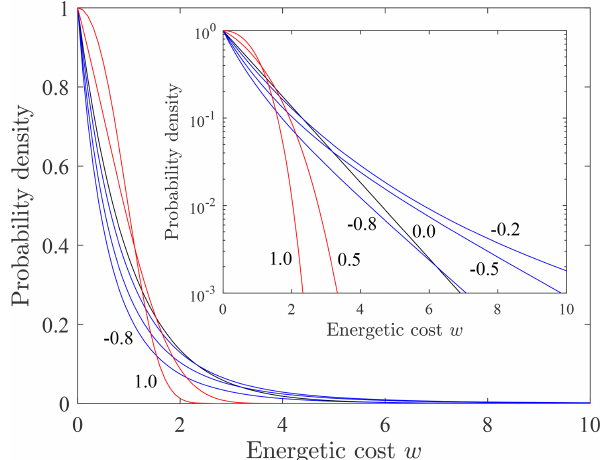
Figure 5. Plot of probability density f w ( w ) of energetic cost w for different values of the shape parameter A , with semi-log plot (inset) showing heavy-tailed form ( A < 0, blue) and light-tailed form ( A > 0, red).